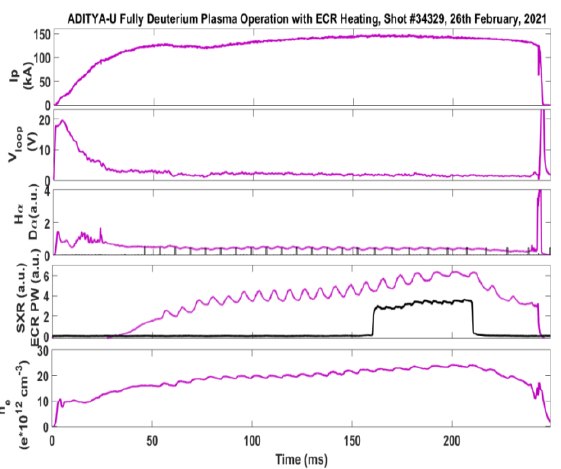
Fig. 4. ECR Heating in deuterium plasma in